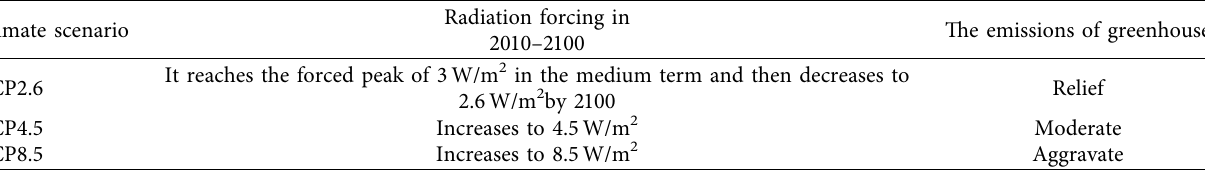
Table 3: Typical concentration path of future climate change recommended in the IPCC ffth assessment